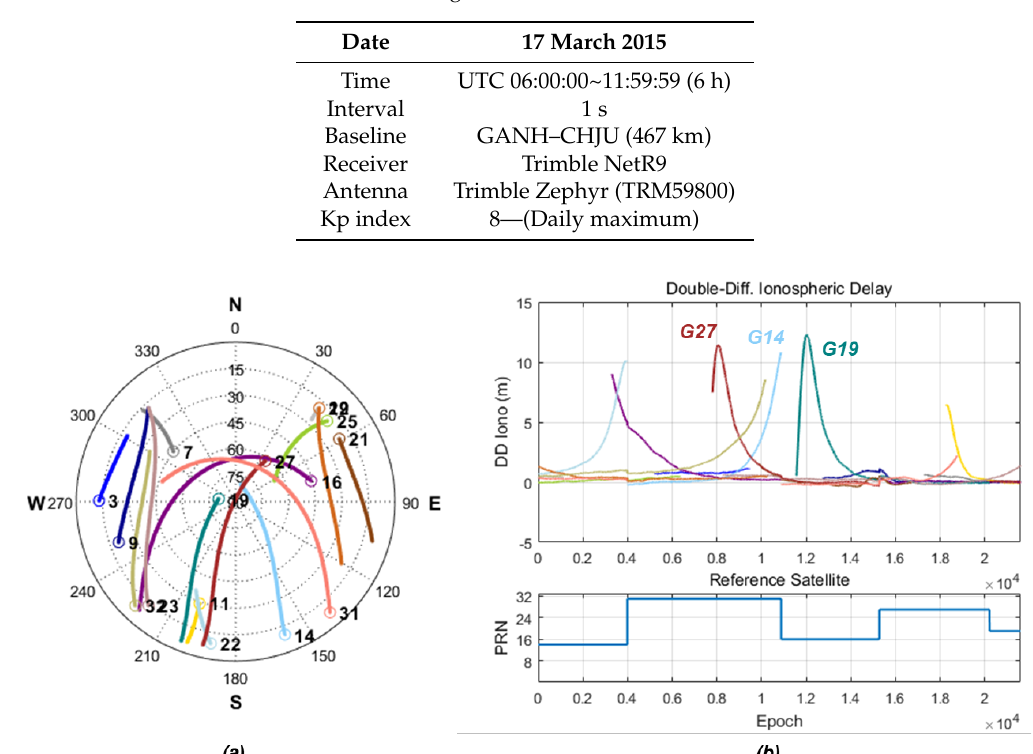
Table 4. Algorithm test environment.